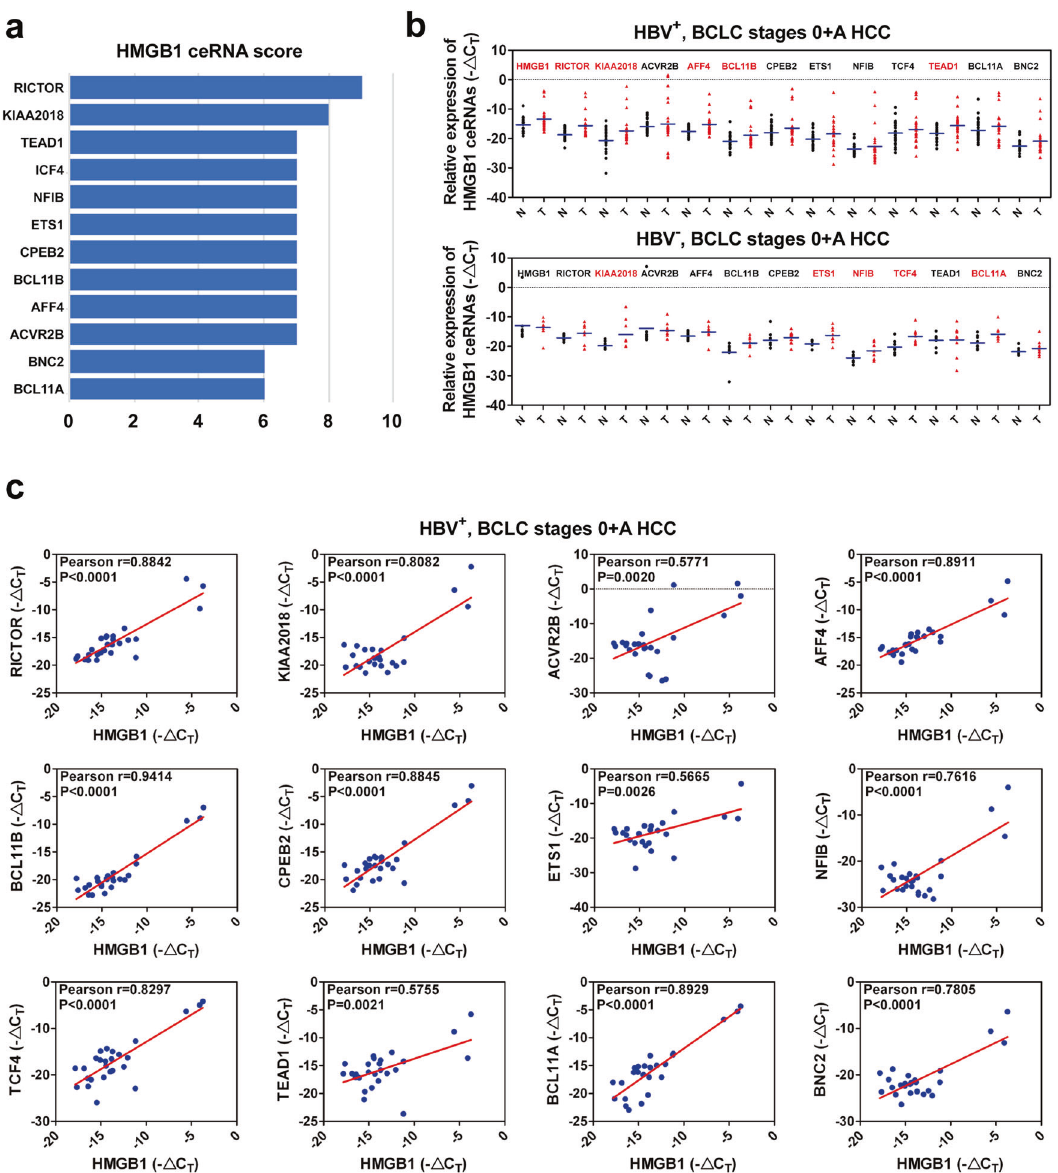
Fig. 1 HMGB1 epigenetically crosstalks with RICTOR in early stage HCC. a Prediction of candidate HMGB1 crosstalk RNAs using the ceRDB database (https://www.oncomir.umn.edu/ce fi nder). The top 12 candidate RNAs and scores were shown. b The RNA expression levels of HMGB1 and the 12 candidate RNAs were analyzed in early stage HCC (BCLC stages 0 and A HCC) tissues by qRT-PCR. HBV + HCC (above) n = 26; HBV − HCC (below), n = 9. The results are means ± SD. Names marked red and black represent signi fi cantly ( p < 0.05) and nonsigni fi cant genes, respectively. c Pearson correlation coef fi cient analysis between expression levels of HMGB1 and the 12 candidate RNAs, respectively, in early stage HCC tumor